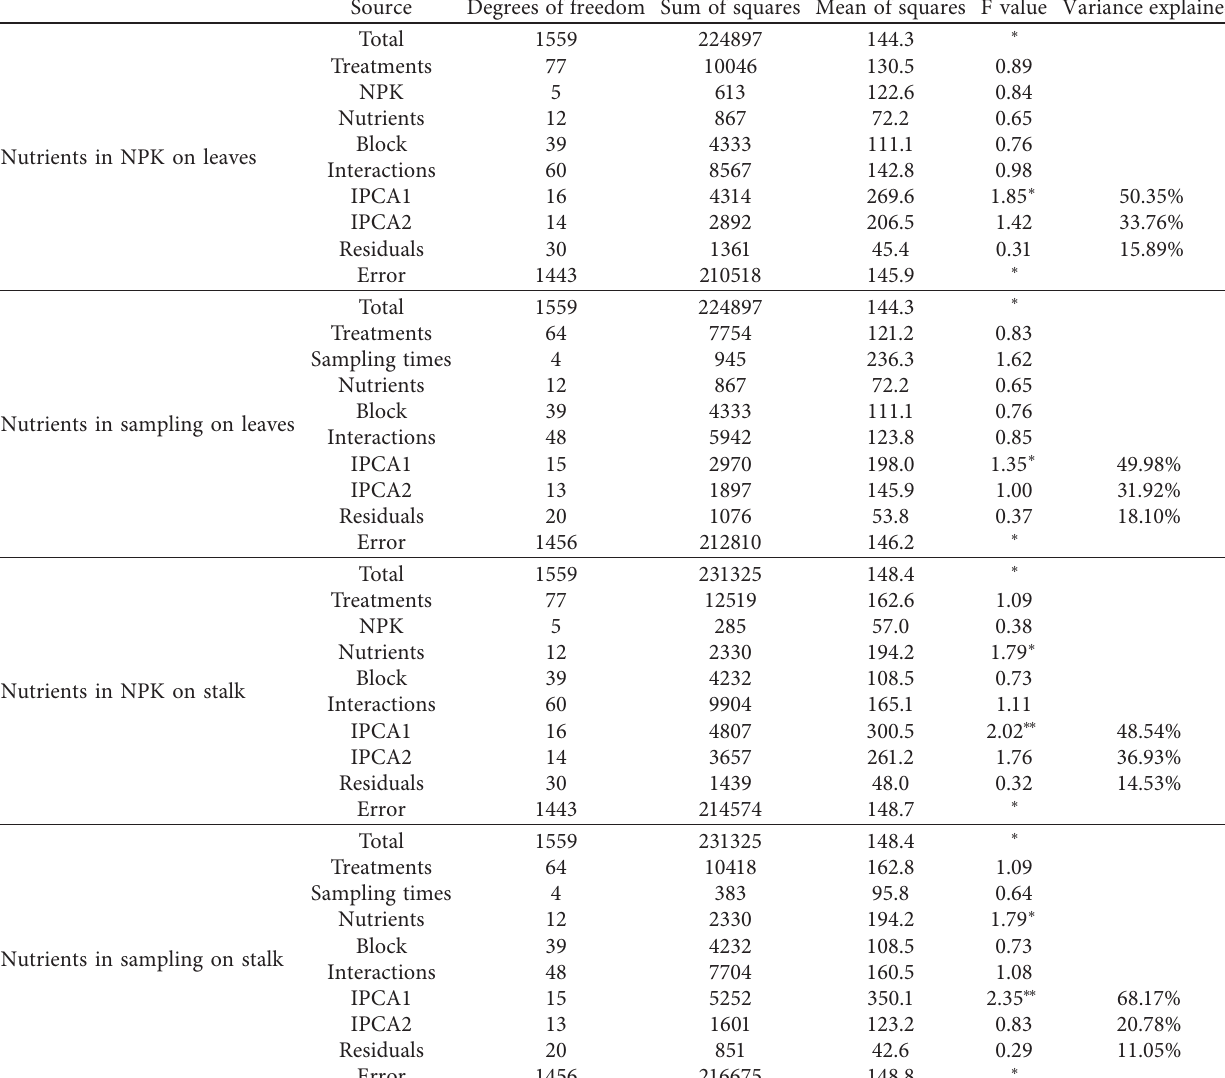
Table 4: AMMI variance analysis on leaves and